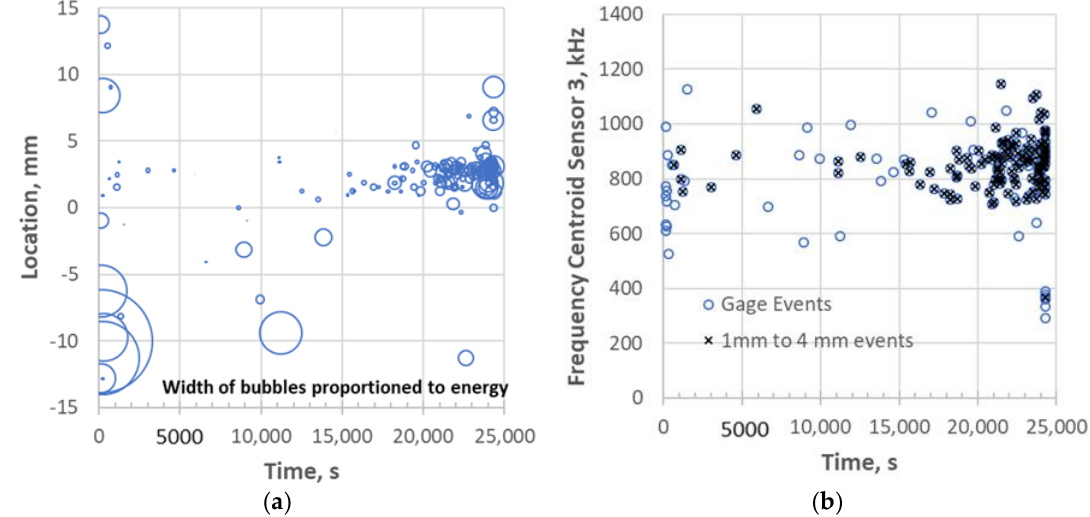
Figure 13. Acoustic emission for 0.01 Hz tested 111-9 specimen: ( a ) location of AE at end of test; and ( b ) frequency centroid of gage events at end of test.